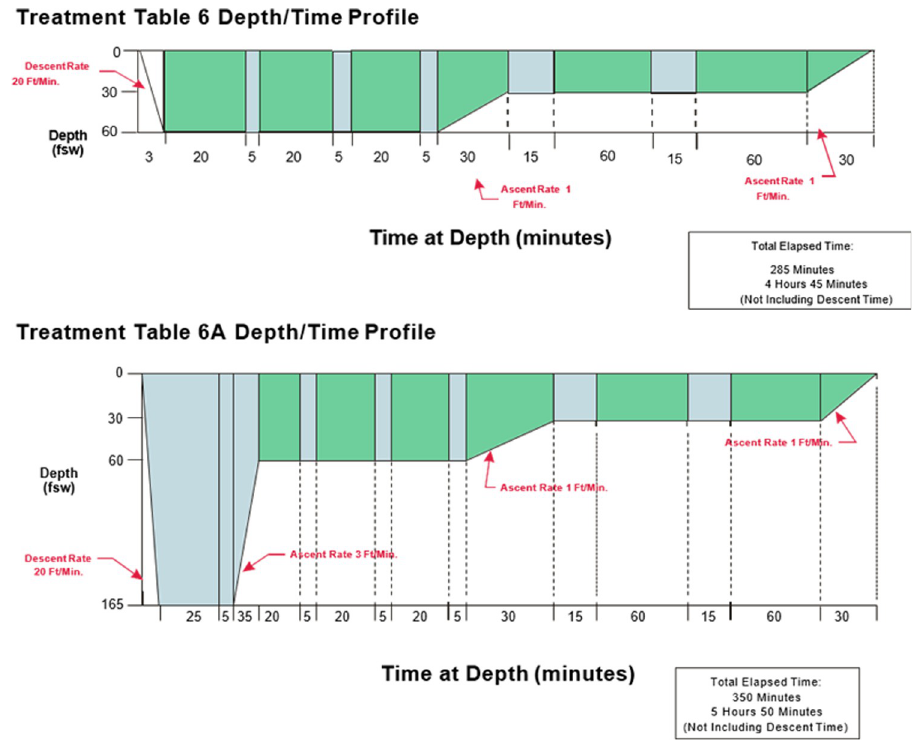
Fig 1. Adapted from US Navy Diving Manual, Revision 7. Depicts dive profile for USN TT6 (A) and USN TT6A (B).